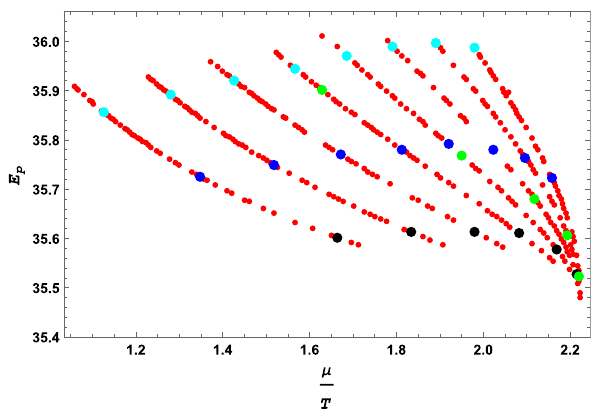
Fig. 6 The EoP with respect to μ for l (cid:3) = 0 . 1, l = 0 . 5 near the critical T point. The blue, cyan and black points show T = 0 . 805, 0 . 995 and 0 . 61, respectively. The green points shows μ = 1 .